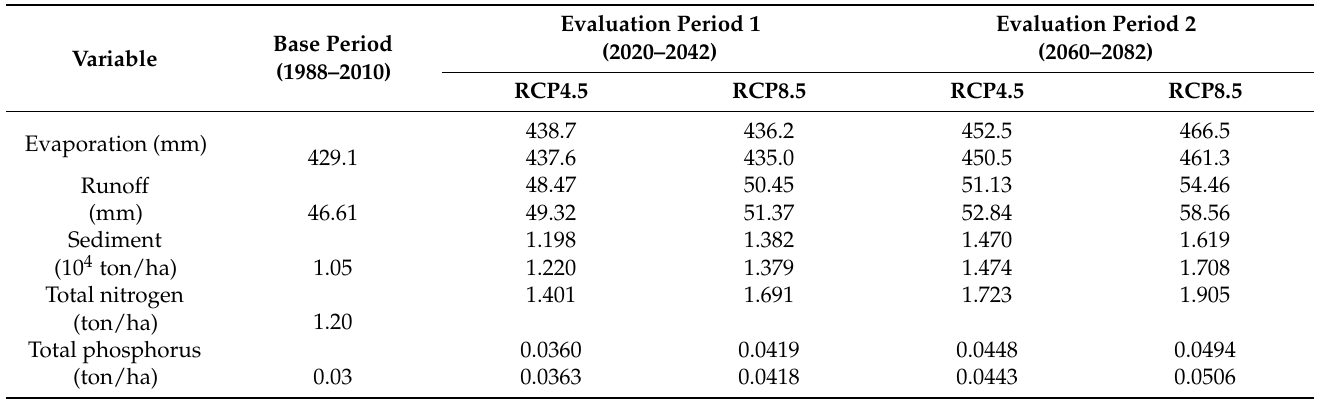
Table 4. Evapotranspiration, water yield, total nitrogen and total phosphorus loads of the land phase in the future.